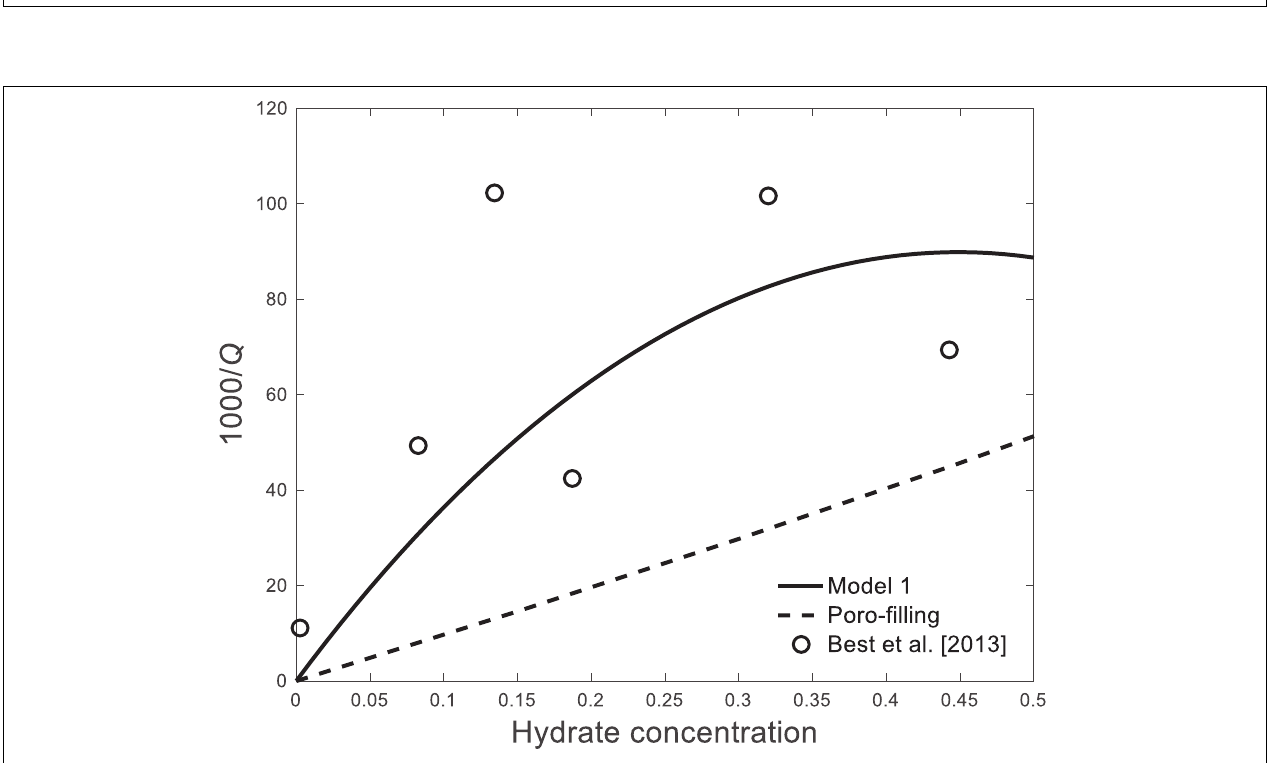
FIGURE 12 | Model 1. Dissipation factor as a function of hydrate concentration. The frequency is around 200 Hz. The pore-filling model and the experimental data (circles) are taken from Best et al. (2013).